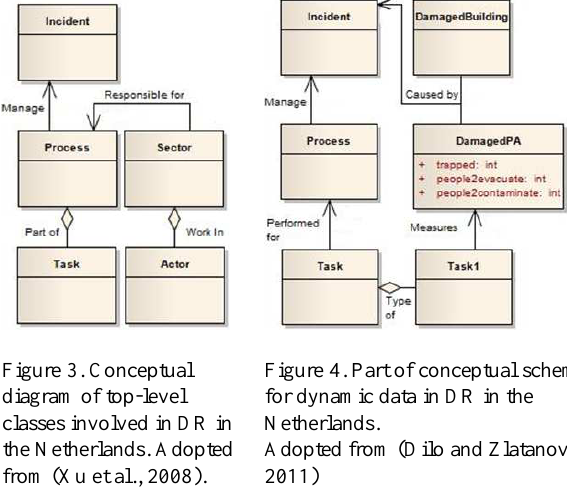
Figure 4. Part of conceptual schema